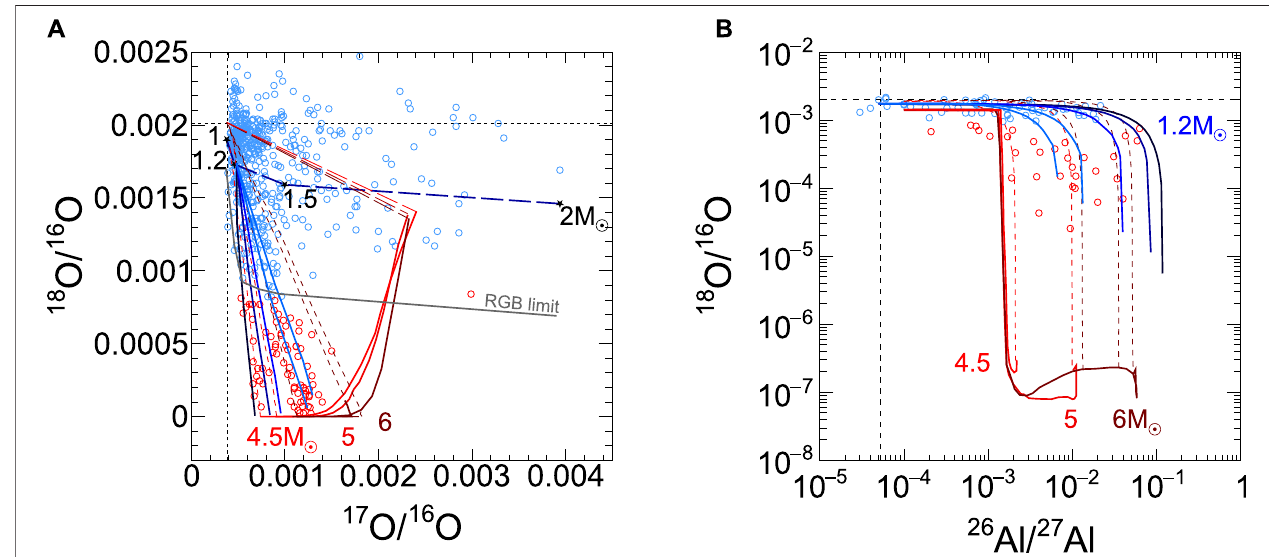
FIGURE4|Panel(A) .Evolutionofthe 17 O/ 16 Oand 18 O/ 16 OisotopicratiosintheenvelopeoflowmassandintermediatemassAGBstarsofsolarmetallicitydueto magnetic mixing (blu curves) and HBB (red curves). Star markers along the blue dashed line indicate the post-FDU composition of stars with mass from 1 to 2 M ⊙ as indicated bythe labels. Open blue circles are group 1oxide grains while red ones are thoseof group2. The descendingblue lines referto magnetic mixingmodel results for a 1.2 M ⊙ AGB star for different values of k , computed employing reaction rates from set A (see the text for details). The maximum modi fi cation of the envelope compositionthatcanbeproducedbythemixingduringtheRGBphaseisindicatedbythegraycurve.Redcurvesdealwiththeevolutionof 17 O/ 16 Oand 18 O/ 16 Oisotopic ratio in the envelope of a 4.5, a 5, and a 6 M ⊙ star affected by HBB, as reported by Lugaro et al. (2017), which runs calculations with reaction rates of set B. The long dashedredlinesindicatetheevolutionoftheoxygenisotopicratiointhestellarevolutionbeforetheAGBphase,whiletheshortdashedredcurvesshoweffectsofdiluting thestellarwindwithearlysolarsystemmaterials(seethetextfordetails).Thetwograydashedlinesmarkthe 17 O/ 16 Oand 18 O/ 16 Osolarvalues. Panel(B) .Samemodels and grain data of plot in panel (A) , but dealing with the 18 O/ 16 O isotopic ratio vs. the 26 Al/ 27 Al one. The horizontal dashed line shows the 18 O/ 16 O solar value while the vertical one the estimate value of the 26 Al/ 27 A in the early solar system as reported by Vescovi et al. (2018).